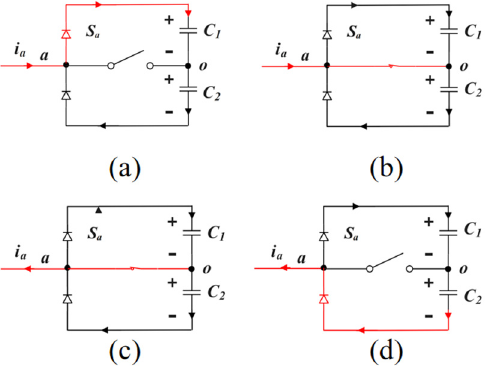
Figure 2. Four working states of Vienna rectifier. ( a ) S a = 0, i a > 0; ( b ) S a = 0, i a > 0; ( c ) S a = 0, i a > 0; ( d ) S a = 0, i a > 0.